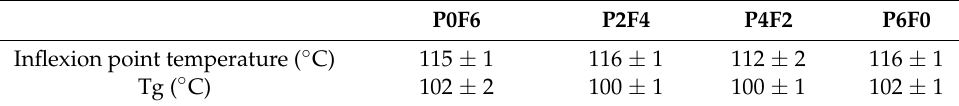
Table 1. Table of the glass transition temperature of composite materials.